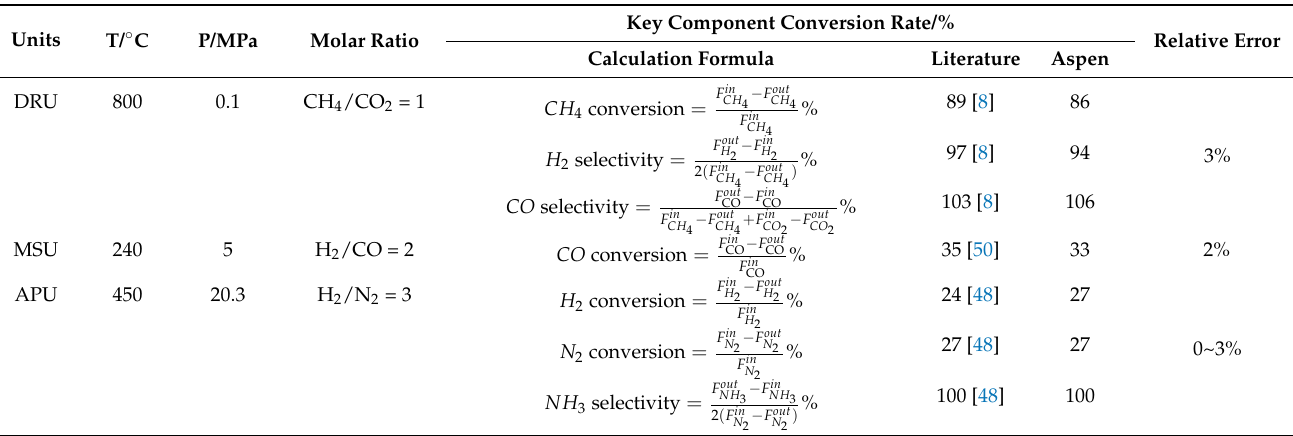
Table 1. Verification of simulation results for the key